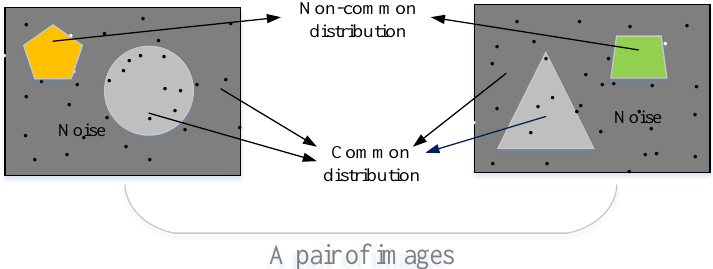
Figure 1. The common distribution and non-common distribution between a pair of